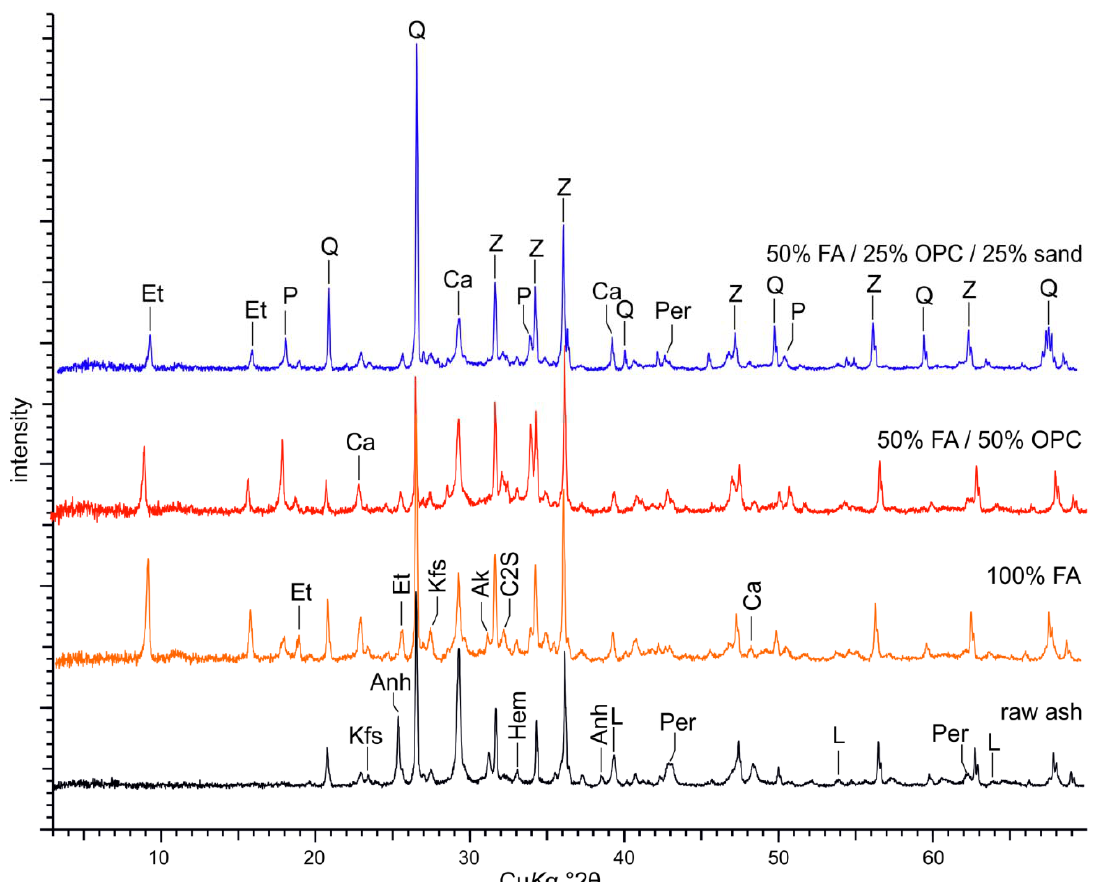
Figure 2. Representative XRD patterns of the activated ash, OPC and sand pastes/mortars after 28 days of curing. Legend for major peaks: Ak—akermanite; Anh—anhydrite; Ca—calcite; C2S—belite; Et—ettringite; Hem—hematite; Kfs—K-feldspar; L—lime; P—portlandite; Per—periclase; Q—quartz; Z—zinc oxide. ZnO spike was added to estimate the amorphous phase content.